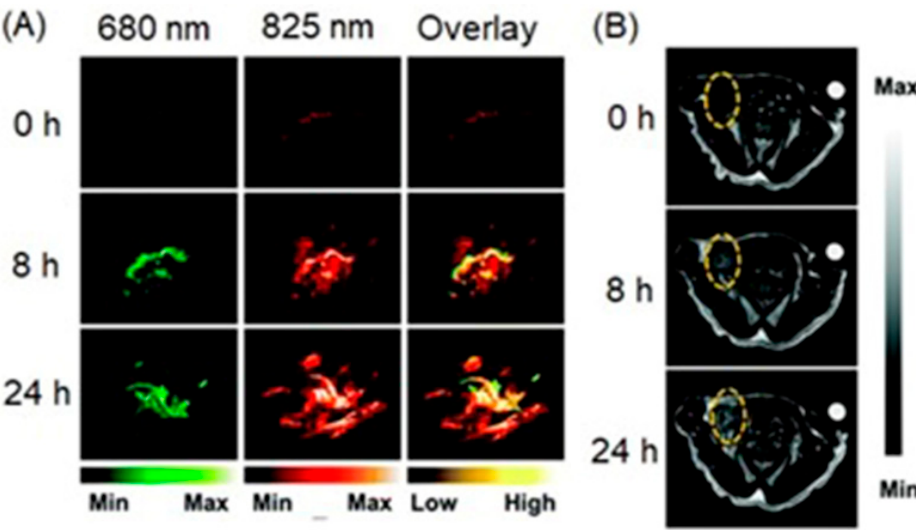
Figure 58. ( A ) Representative photoacoustic images and ( B ) representative T 1 -weighted images of 4T1 neoplastic mice after tail vein injection of nanoparticles. The two photoacoustic imaging channels represent hydrogen peroxide/pH-sensitive MnO 2 nanoparticles that exhibit photoacoustic signal at 680 nm and hydrogen peroxide/pH-inert polymeric nanoparticles that exhibit photoacoustic signal at 825 nm. Adapted with permission of the Royal Society of Chemistry, from Intelligent pol- ymer–MnO 2 nanoparticles for dual-activatable photoacoustic and magnetic resonance bimodal im-